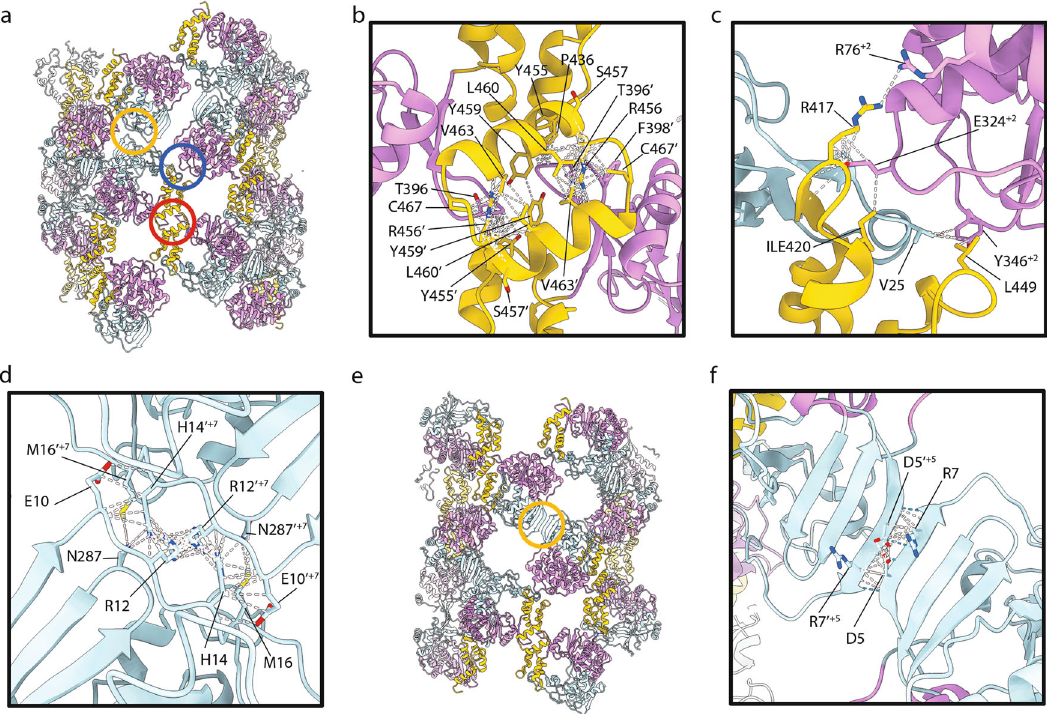
Fig. 6 Molecular interactions within the fi bril. a The pseudoatomic model for fi bril N3 is shown as cartoons coloured according to the subdomain structure of 3D pol ; palm subdomain (plum), fi ngers subdomain (powder blue) and thumb subdomain (gold). Three interactions between monomers are highlighted: dimer interface (red circle), inter-dimer interface (blue circle) and inter-proto fi lament interface (yellow circle). Close-up views of the dimer interface b , inter-dimer interface c , and inter-proto fi lament interface d are presented for N3 with contacts/clashes highlighted by white dashed lines and sidechains of putative contact residues shown. e The pseudoatomic model of N9 is annotated to highlight the inter-proto fi lament interaction in this conformation (yellow circle), which is shown in close-up view with contacts/clashes highlighted with white dashed lines and putative hydrogen bonds indicated by blue dashed lines f